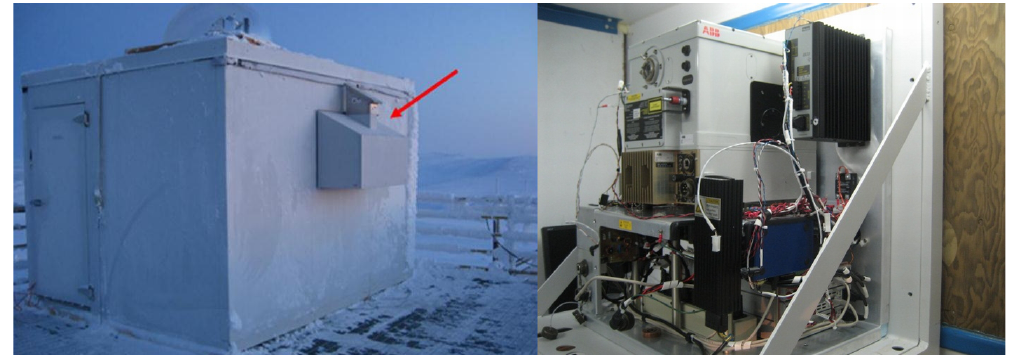
Fig. 1. Exterior (left panel, red arrow) and interior (right panel) views of the E-AERI installed on the roof of the PEARL Ridge Lab using the thru-wall configuration. Left panel: front-end portion of the E-AERI instrument housing the optics; the hatch is closed during precipitation events (photo: Stephane Lantagne). Right panel: the back-end portion of the E-AERI instrument with its internal protective enclosure temporarily removed to show the MR-300 series interferometer housing and electronic modules (photo: Zen